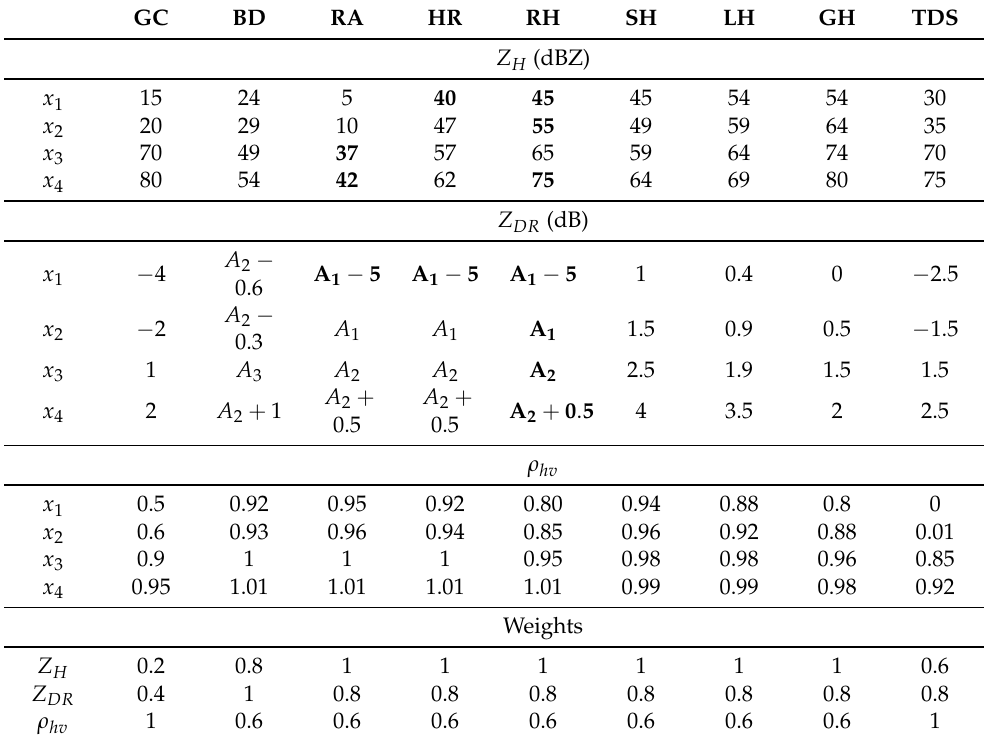
Table 2. Hydrometeor classification algorithm (HCA) membership functions and weights for ground clutter (GC), big drops (BD), rain (RA), heavy rain (HR), and rain/hail (RH) classes for X-band adapted from [63] with bolded numbers highlighting modified values— A 1 and A 2 are two- dimensional functions of Z H as in [63]. S-band functions for the aforementioned classes are not listed but are given in [71]. Membership functions and weights for the small hail (SH), large hail (LH), and giant hail (GH) classes are adapted from [72] while tornado debris signature (TDS) membership values are from [49]; values for these four classes are implemented for both X- and S-band.